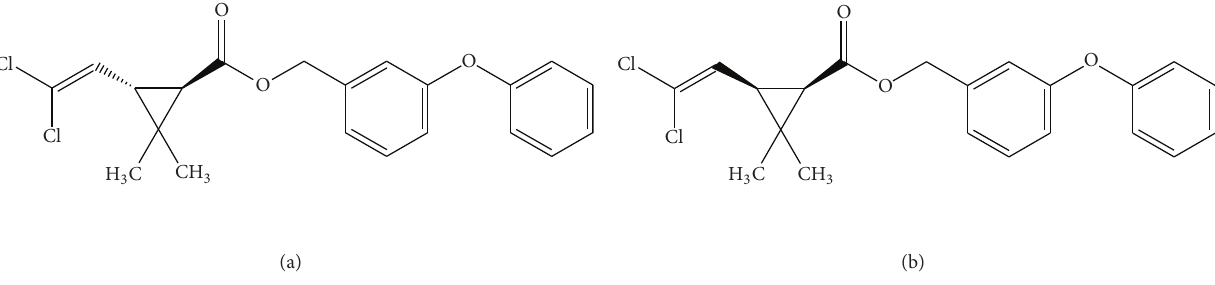
F 1: Molecular structures of (a) trans - and (b) cis